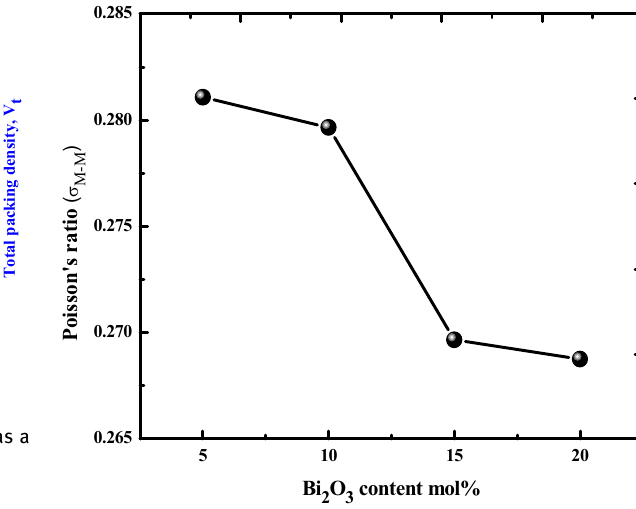
Figure 4: Variation of Poisson ’ s ratios as a function of Bi 2 O 3 content mol% for all S1 – S4 glasses.